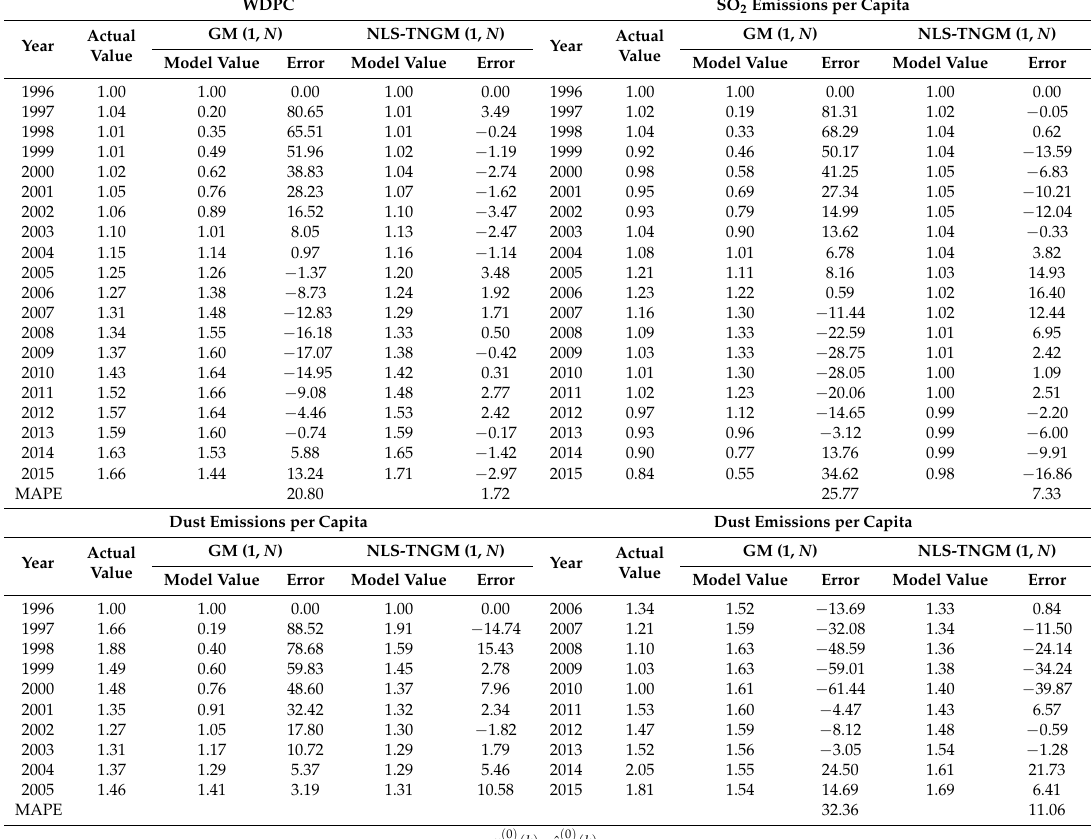
Table 3. Forecasting values and errors of three pollutants using two models.